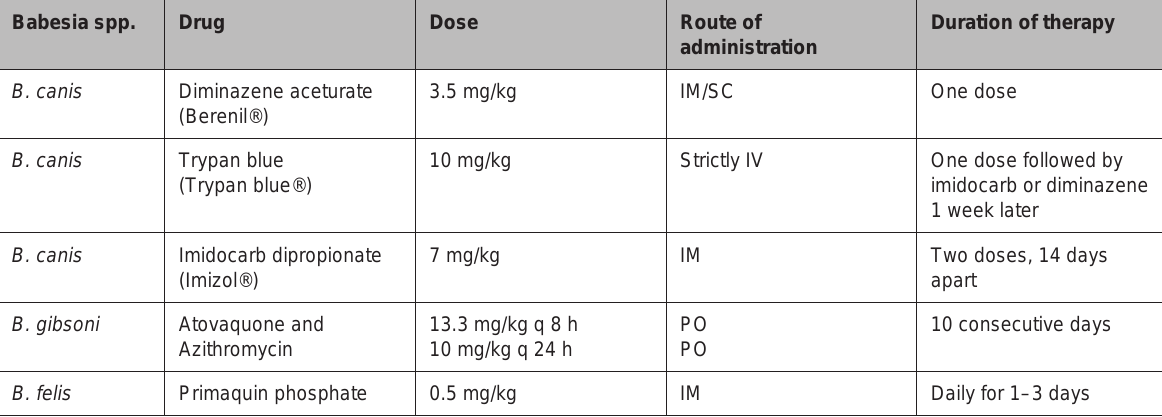
TABLE 2 Drugs used in the treatment of babesiosis Babesia